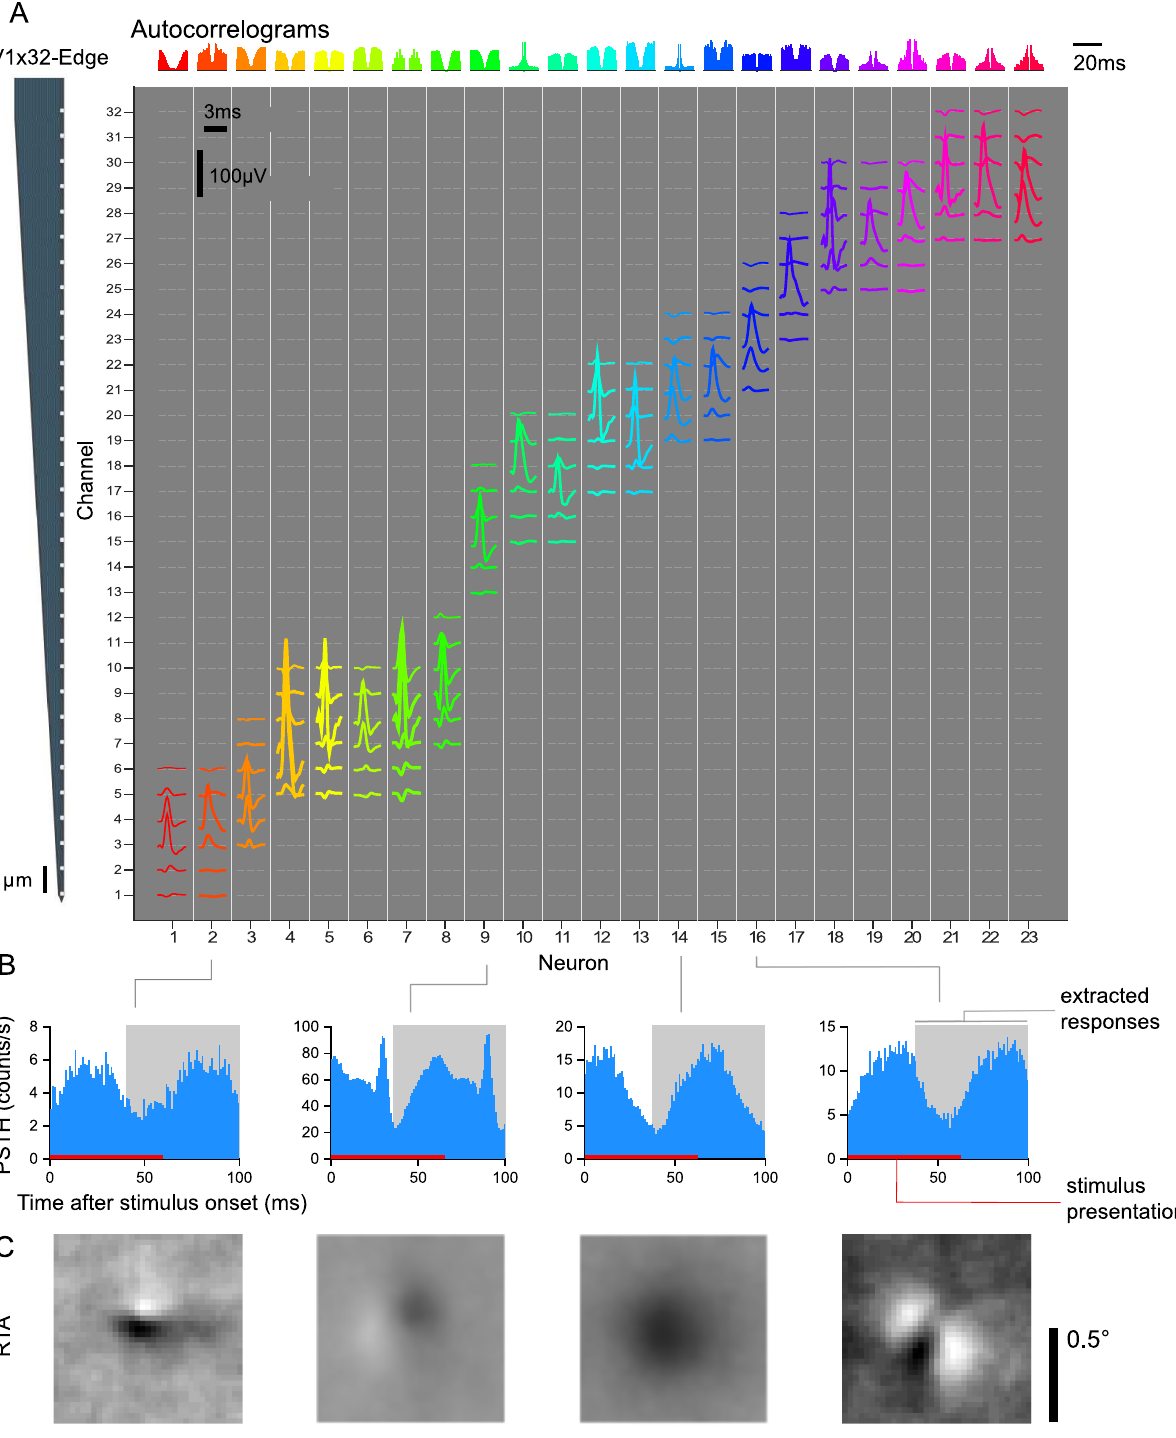
Fig 2. V1 electrophysiological responses. A: Isolated single-unit activity. We performed acute recordings with a 32-channel, linear array (NeuroNexus V1x32-Edge-10mm-60-177, layout shown in the left) to record in primary visual cortex of two awake, fixating macaques. The channel mean-waveform footprints of the spiking activity of 23 well-isolated neurons in one example session are shown in the central larger panel. The upper panel shows color- matched autocorrelograms. B: Peri-stimulus time histograms (PSTH) of four example neurons from A. Spike counts where binned with t = 1 ms, aligned to the onset of each stimulus image, and averaged over trials. The 60 ms interval where the image was displayed is shown in red. We ignored the temporal profile of the response and extracted spike counts for each image on the 40–100 ms interval after image onset (shown in light gray). C: The Response Triggered Average (RTA) calculated by reverse correlation of the extracted